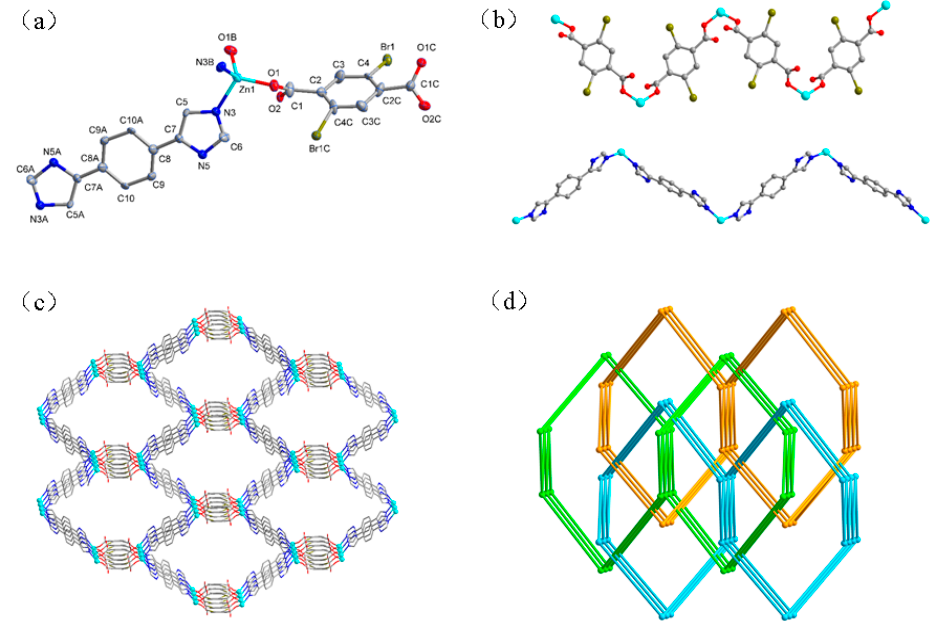
Figure 2. ( a ) The coordination environment of the Zn(II) atoms in 2 . Symmetry code: A 2 − x, 1 − y, 1 − z, B x, 0.5 − y, 0.5 − z, C 0.5 − x, − y, z. ( b ) 1D chains of [Zn(II) (Brpbda 2 − )] and [Zn(II)(L)] in 2 . ( c ) 3D framework of 2 . ( d ) Schematic representation of the 3-fold interpenetrating dmp net with a (6 5 ·8) topology.